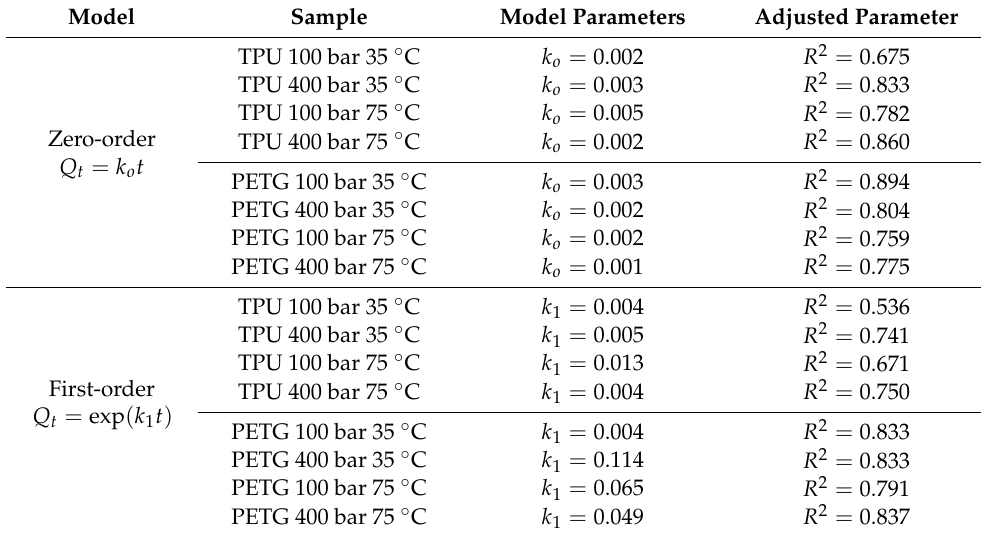
Table 7. Mathematical models for MLE release.